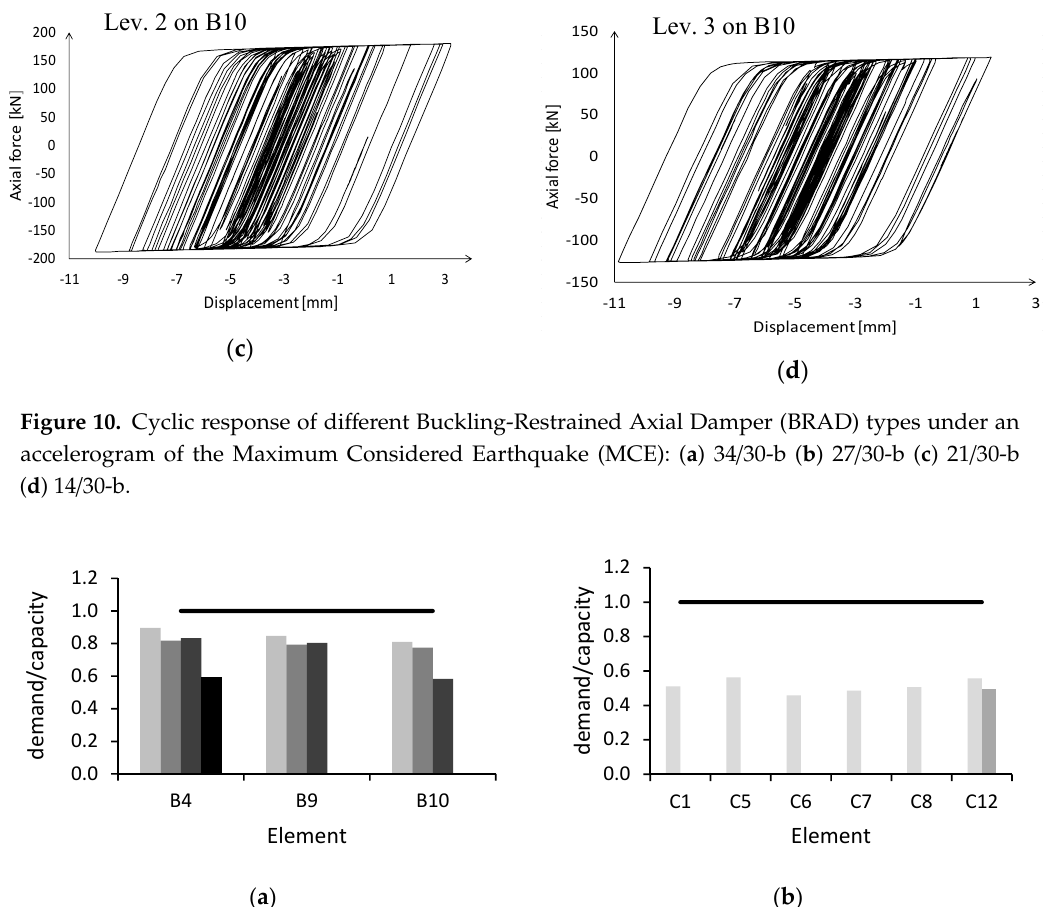
( b ) Figure 12. Shear verifications after retrofit of: ( a ) beams and ( b ) columns. From this figure it can be observed that, thanks to the retrofit intervention, the demand/capacity ratio is always lower than 1. For example, beam B4, which did not satisfy the shear verification in the as-built condition, after the retrofit intervention shows a reduction in the acting shear of about 57% (from 23.4 kN to 10.1 kN). On average, the reduction in the acting shear is of 55% for beams and 64% for columns. These results show the great benefits obtained from the use of the dissipative system. Regarding verification of beam–column joints, many of them are still not verified even after retrofit. Hence, for improving their performance, local strengthening interventions are needed. Regarding the walls, verifications are already satisfied in the as-built configuration, before the introduction of the dissipative devices.